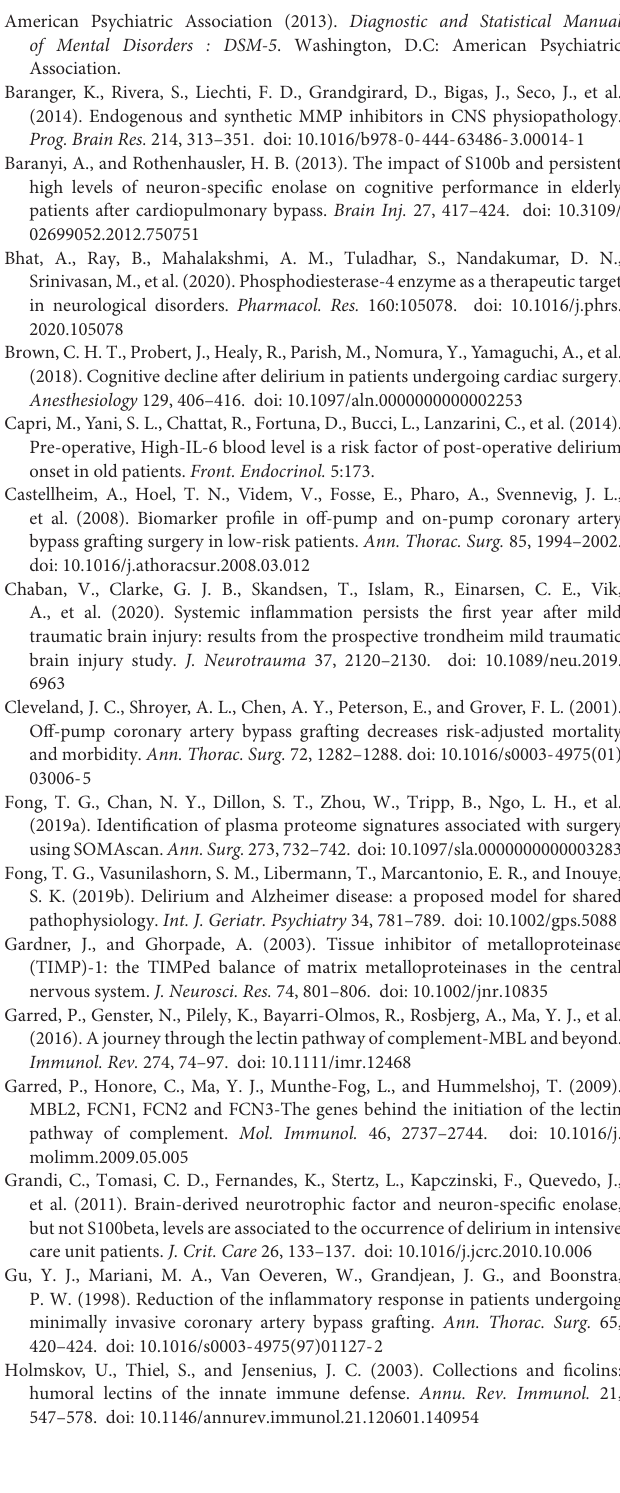
(postoperative/preoperative level) PODgroup ÷ (postoperative/preoperative level) non − PODgroup . Those proteins in orange satisfied absFC > 1.5 and green met both p adj < 0.05 and FC